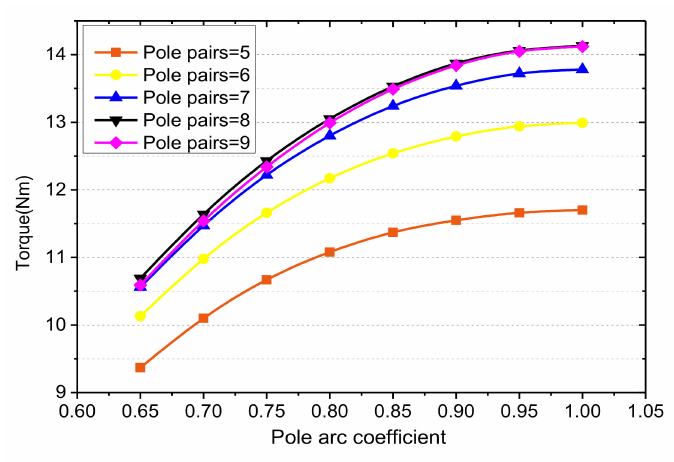
Figure 15. T max versus pole arc coe ffi cient for several pole pairs.